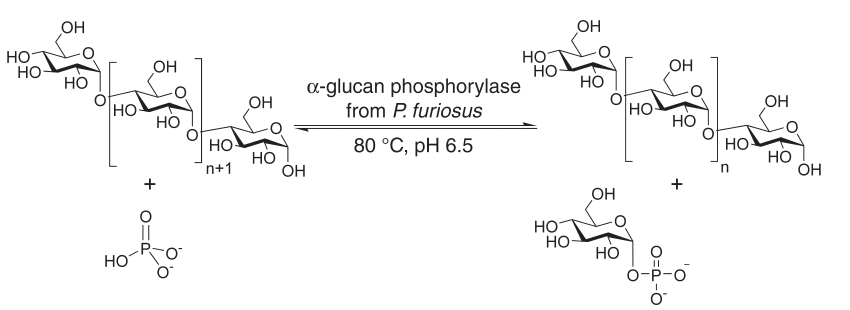
Figure 1. Schematic diagram of the reac- tion catalyzed by α -glucan phosphorylase from Pyrococcus furiosus . The glucose molecule is liberated from the non-reduc- ing end of the glucose polymer to form α - D